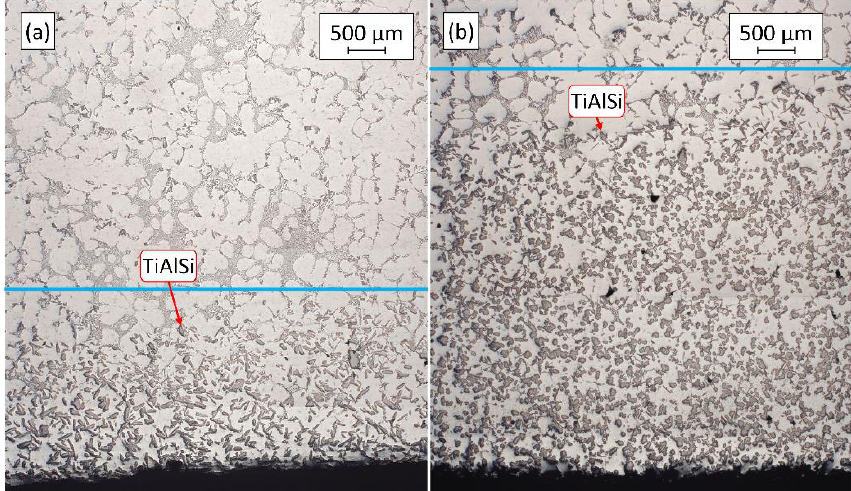
Figure 4. Settled TiAlSi particle-rich zones formed during ( a ) experiment A1 and ( b ) A2. Table 2. Sediment layer height values.